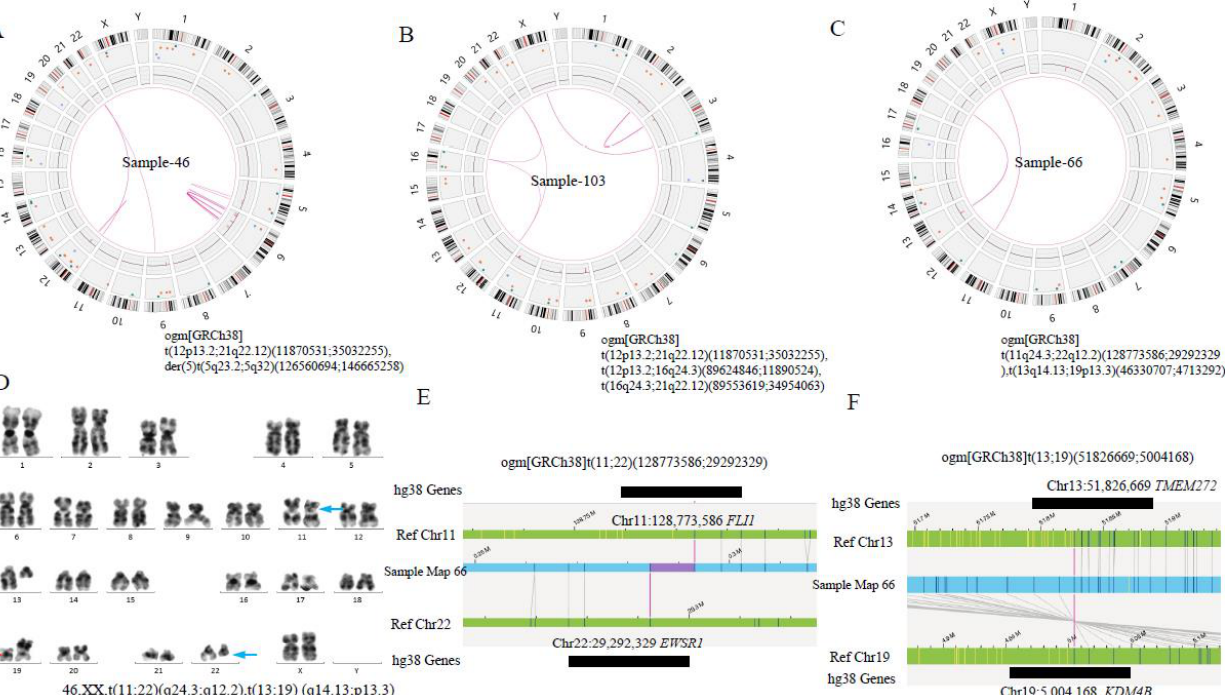
Figure 4. Identification of additional SV findings by OGM. ( A ) Circus plot showed a translocation between chromosomes 12 and 21 and the internal rupture of chr5, resulting in the formation of a derivative chromosome in case 46. ( B ) Circus plot showed three-way translocations between chr12 and 21, chr12 and 16, and chr16 and 21, respectively, in case 103. ( C ) Circus plot showed two translocations between chr11 and 22, chr13 and 19 in case 66, respectively. ( D ) Standard G- banded karyotyping showed t (11;22) (q24.3; q12.2) (blue arrow) and t(13;19) (q14.13;q13.3) (red arrow). ( E , F ) Linear genome browser representation of known FLI1 :: EWSR1 fusion and a novel TMEM272 :: KDM4B fusion in case 66. Green represents GRCh38 reference chromosomes with OGM label patterns. Light blue represents assembled sample maps with label patters. Grey lines represent label alignments between two maps. Purple represents translocation breakpoints. Black lines rep- resent the genes in this region.